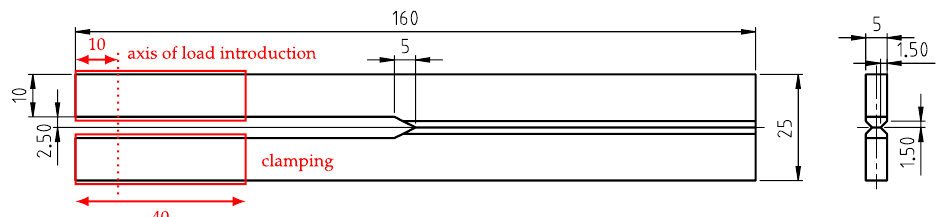
Figure 3. Geometry of the tested polyoxymethylene homopolymer (POM-H) specimens (in mm). The specimens were notched via pushing with a thin razor blade (notch depth